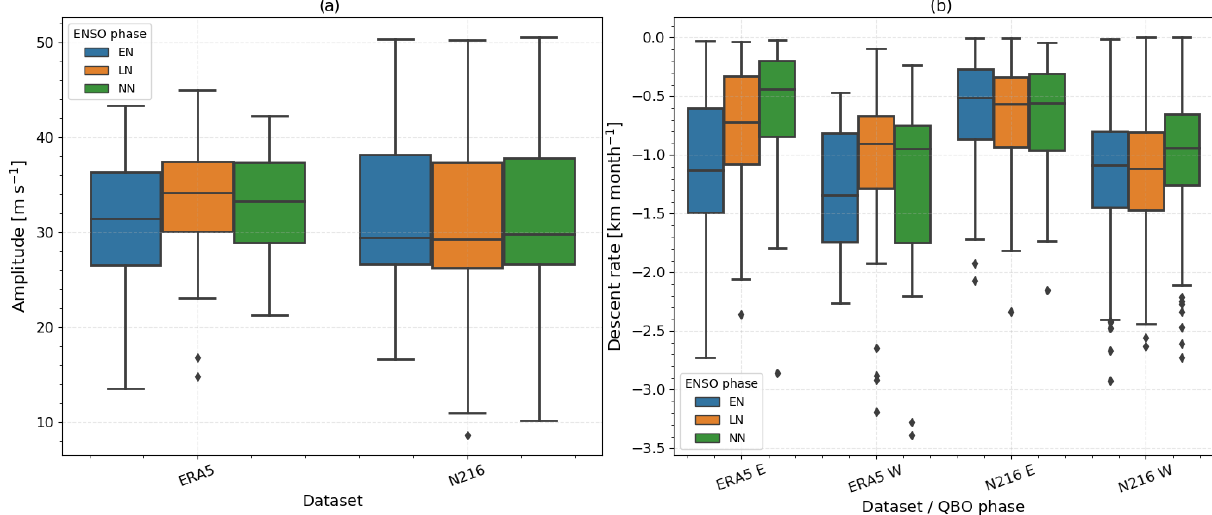
Figure 6. Box plots of the median (horizontal line), first and third quartiles (boxes), and minimum and maximum (delimited by the whiskers) of the distribution of QBO (a) amplitudes [ms − 1 ] and (b) descent rates [km per month] separated by dataset (ERA5 and GC3 N216-pi) and ENSO phase. NN stands for ENSO-neutral. In panel (b) descent rates are shown for both descending easterly (E) and westerly (W) phases following Schenzinger et al.